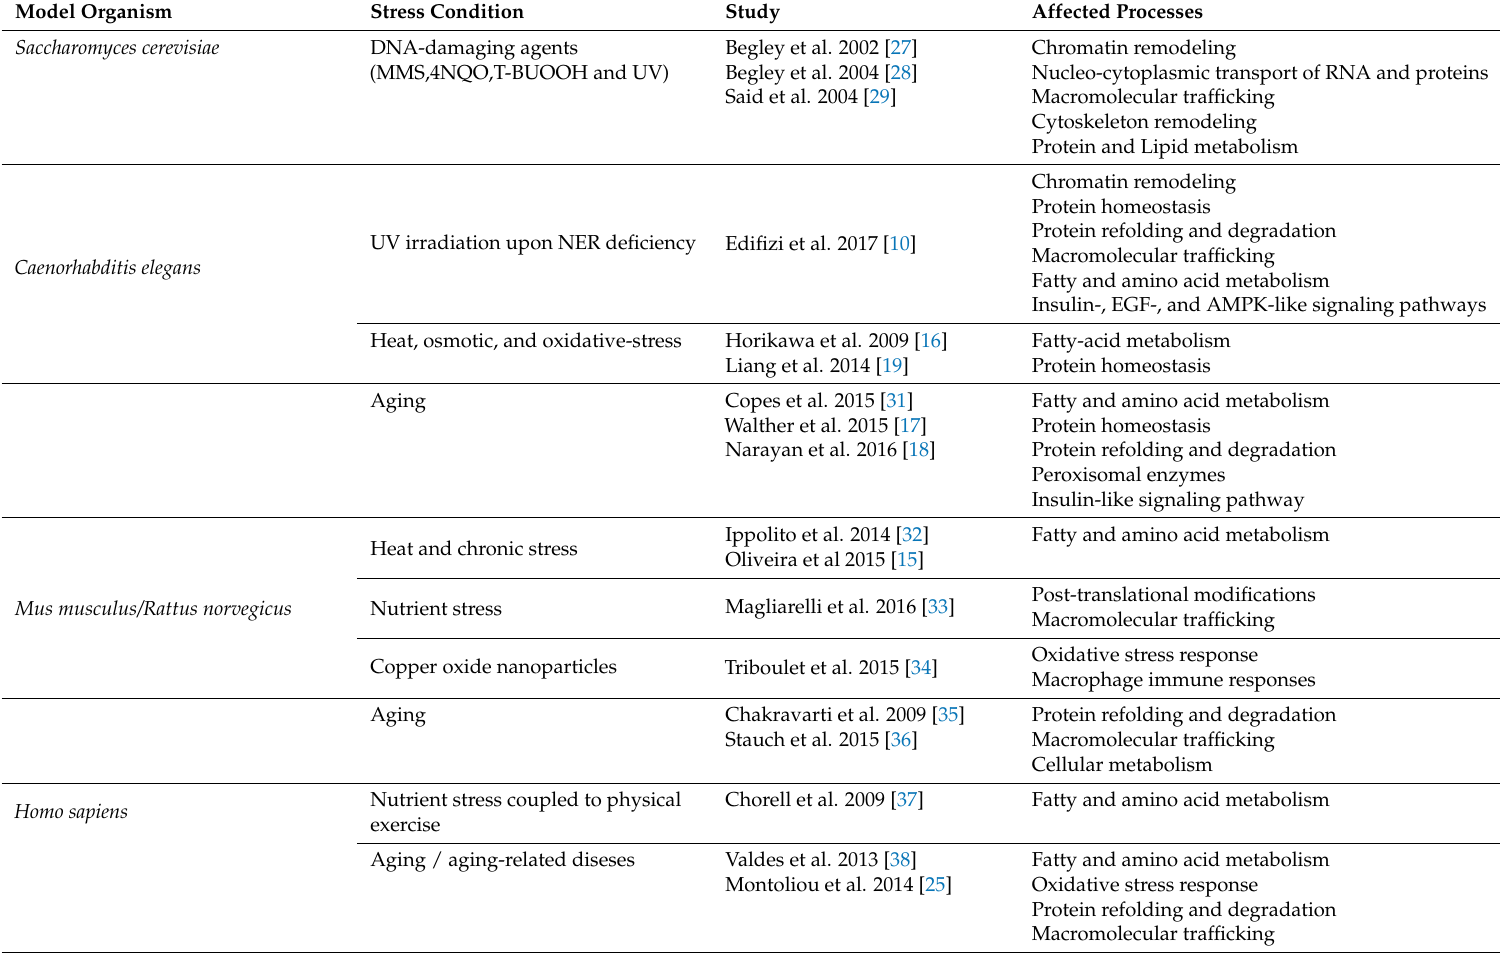
Table 1. Omics approaches applied to model organisms to identify the molecular mechanisms mostly involved upon stress